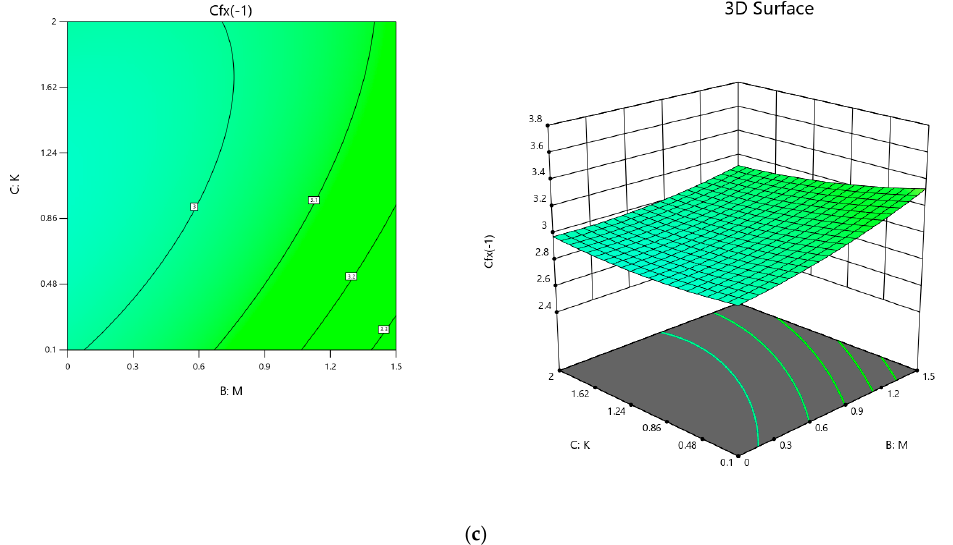
Figure 14. Three-dimensional surfaces and contour plots for all continuous parameters of M, R, and K on Cfx.